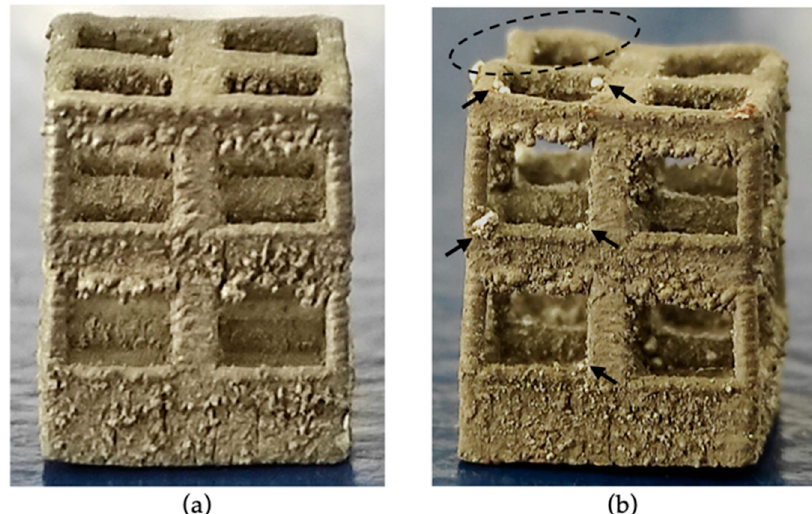
Figure 11. Photographs of lattice structures in as-produced conditions ( a ) and after 100 cycles across Sn melting temperature ( b ). In image ( b ), the dashed ellipse highlights a deformed region of the lattice, and the arrows point out Sn droplets.